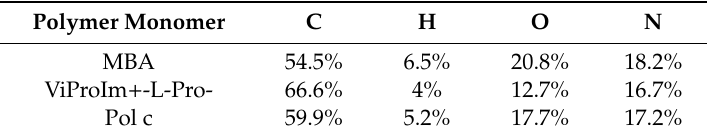
Table 1. The elemental analysis